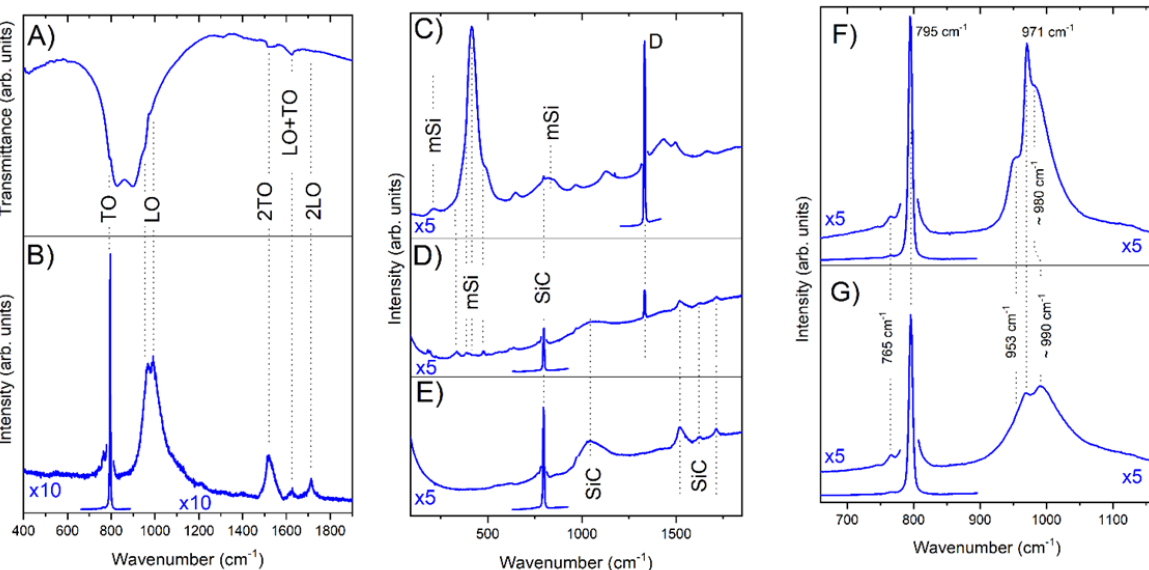
Figure 3. ( A ) IR transmission spectra of SiC crystals near lattice resonances. ( B ) Raman spectra upon excitation of the crystal by radiation with a wavelength of 632 nm. ( C – E ) Raman spectra for the following individual particles found in the sample synthesized in Ti capsule at 1600 ◦ C: ( C ) a particle, mainly consisting of a diamond phase and metastable silicon; ( D ) a particle comprising SiC, a diamond phase, and metastable silicon; ( E ) silicon carbide crystal. Raman spectra for submicron particles, synthesized at 1350 ◦ C, before ( F ) and after annealing ( G ) in the region corresponding to the first-order processes with participation of optical phonons. The spectra in Panel ( C – G ) were recorded using 532 nm excitation.